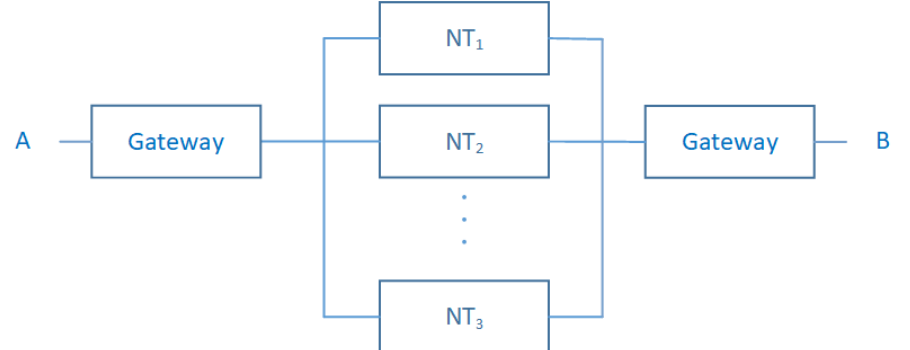
Figure 9. Access Network RBD